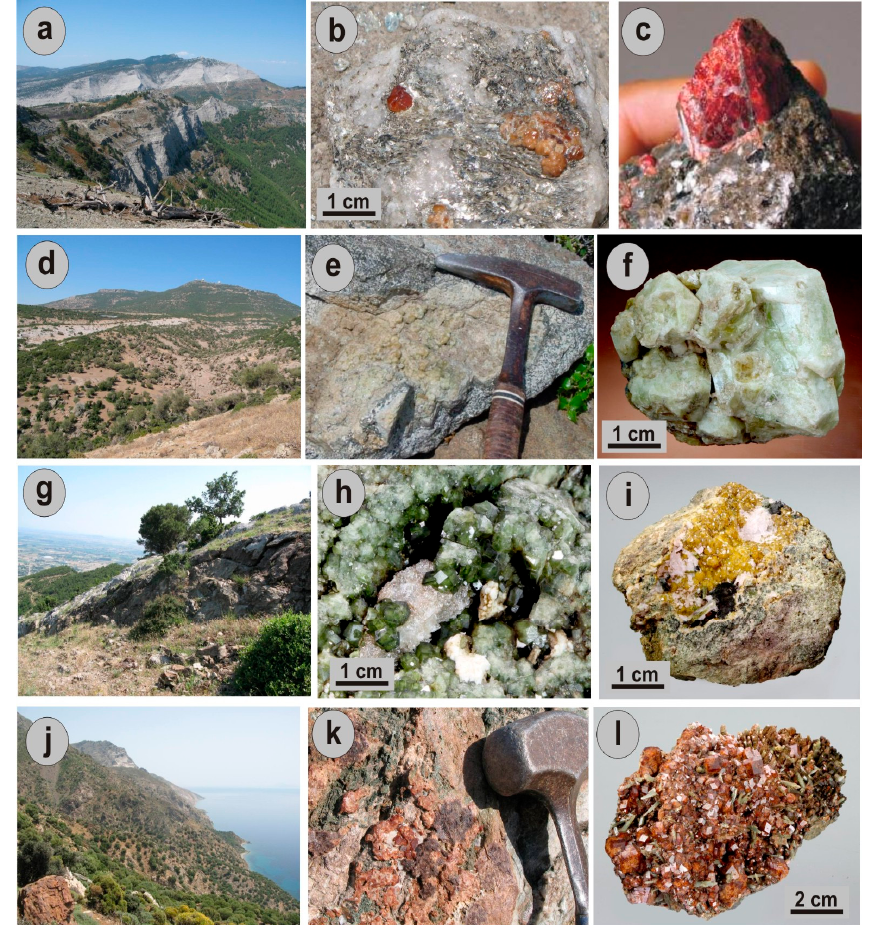
Figure 7. Field and hand specimens photographs demonstrating gem garnet occurrences/crystals of Greece: ( a ) alternating marbles and metapelites at Trikorfo, Thassos Island. Metapelites host spessartine together with other Mn-bearing silicates; ( b ) spessartine crystals associated with muscovite within quartz matrix; ( c ) spessartine within braunite-phlogopite bearing skarn from Thapsana. Paros Island; ( d ) Maronia skarn at the interface between marbles and the Maronia pluton (half right part of the photograph); ( e ) grossular crystals in contact with the Maronia monzogabbro; ( f ) partly transparent pale green grossular crystals from the Maronia skarn; ( g ) andradite-bearing wollastonitic skarn in contact with marbles, Kimmeria, Xanthi; ( h ) Green andradite and calcite from Kimmeria, Xanthi; ( i ) yellow andradite within amphibolite, Kimmeria, Xanthi; ( j ) Panoramic view of skarn at Dikeon Mt, southern Kos Island; ( k ) orange andradite and diopside from the Dikeon Mt skarn, Kos Island; ( l ) red-brown andradite with green quartz from Avessalos, Serifos Island. Photographs 7 f,h,i,l are courtesy of Berthold Ottens. Deep red colored spessartine crystals up to 3 cm at Paros Island / Cyclades, are related to